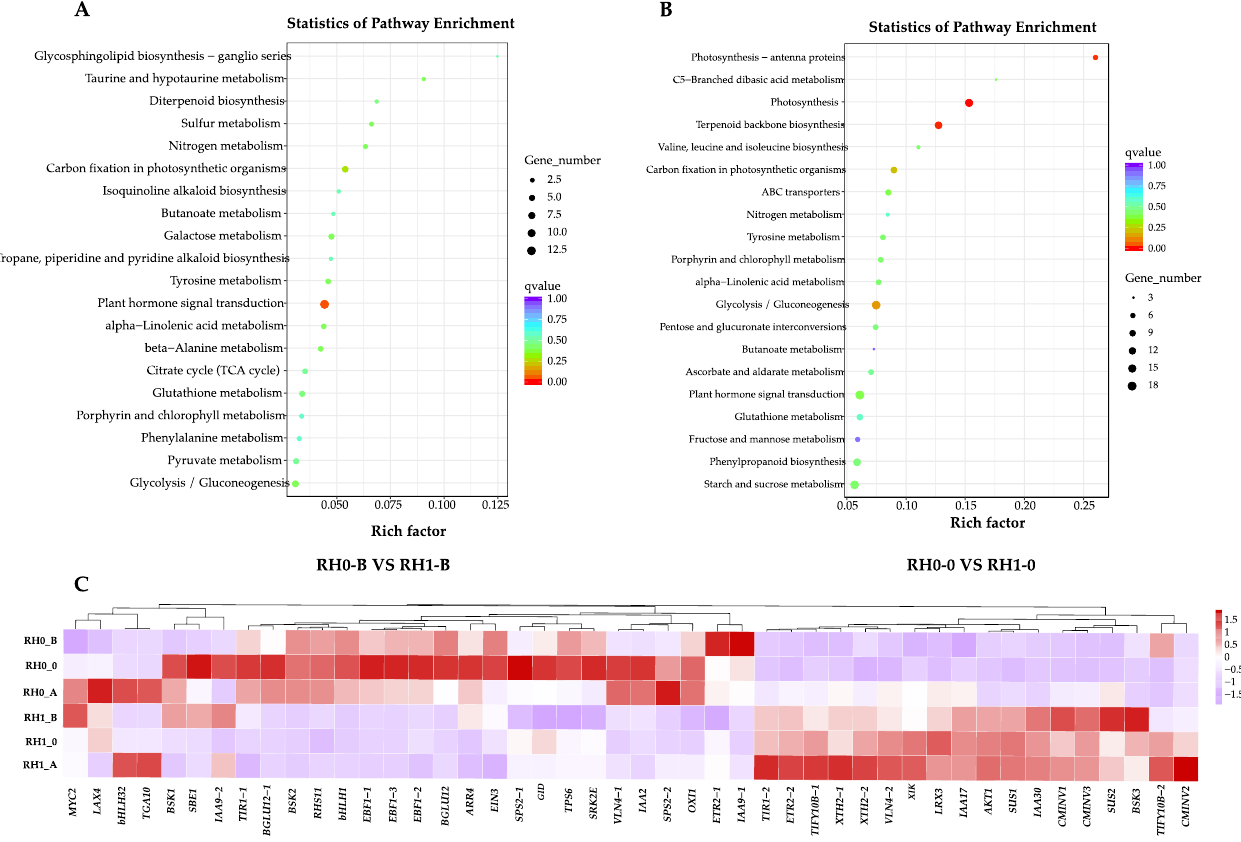
Figure 4. Identification of DEGs involved in hormone and sugar signal transduction at different development stages of two-type roots in A. beshanzuensis . ( A ) Identification of DEGs involved in hormone signal transduction in groups of RH0_B, RH0_0, RH1_B and RH1_0 from A. beshanzuensis . ( B ) Identification of DEGs involved in sugar pathway in groups of RH0_B, RH0_0, RH1_B and RH1_0 from A. beshanzuensis . ( C ) Cluster expression patterns of important DEGs involved in pathway of sugar, hormone and root hair growth and development in groups of RH1_B, RH1_0, RH1_A, RH0_B, RH1_0, and RH1_A of A. beshanzuensis .